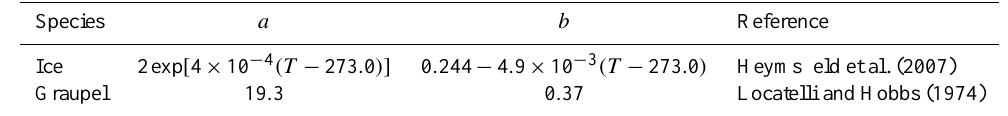
Table 2. Parameters of the terminal velocity relation w term = aD b y ( 1000 /p) 0 . 4 (SI units) for convective ice species.